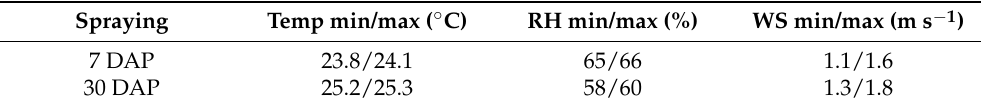
Table 6. Values of minimum and maximum temperatures (TEM MIN/MAX), minimum and maxi- mum relative humidity (RH min/max), minimum and maximum wind speed (VV MIN/MAX) in the Northeast direction after 7 and 30 days of planting the conilon coffee seedlings in pots in the